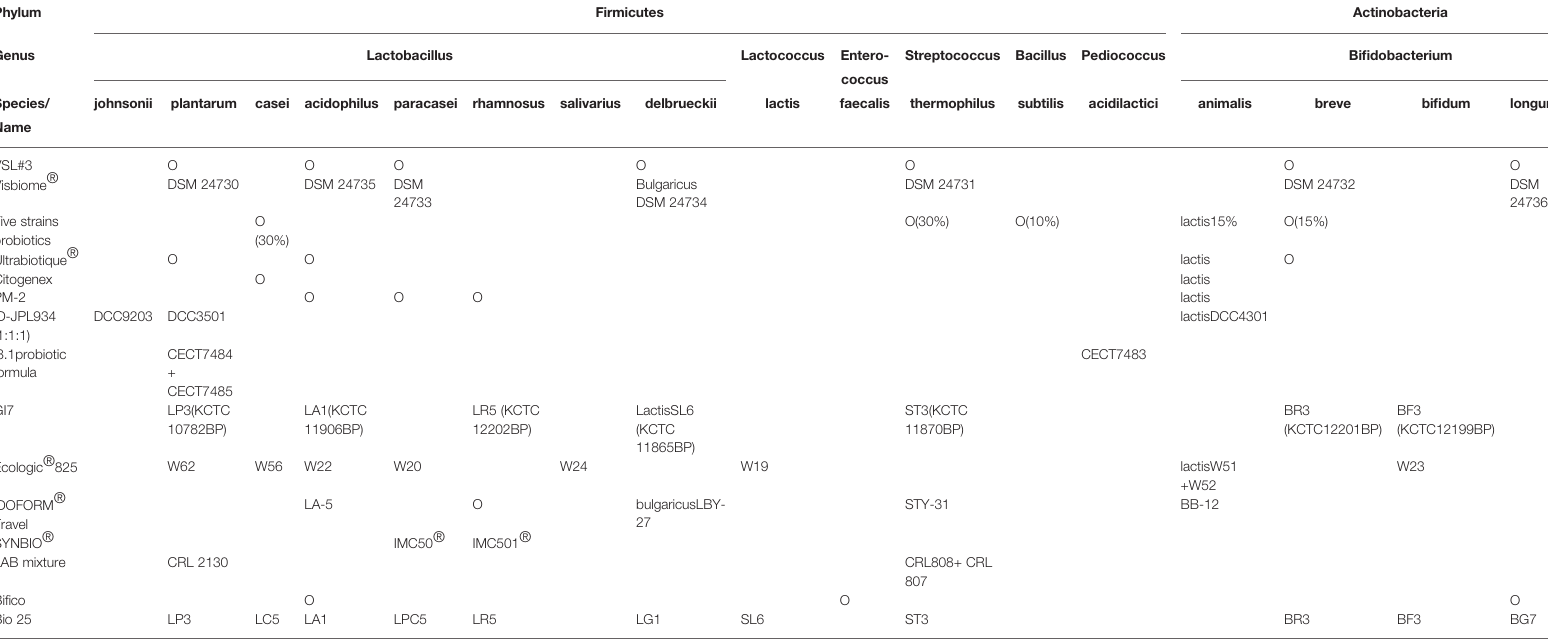
“ O ” indicates the existence of the strain in this product, but the speci fi c strain is not